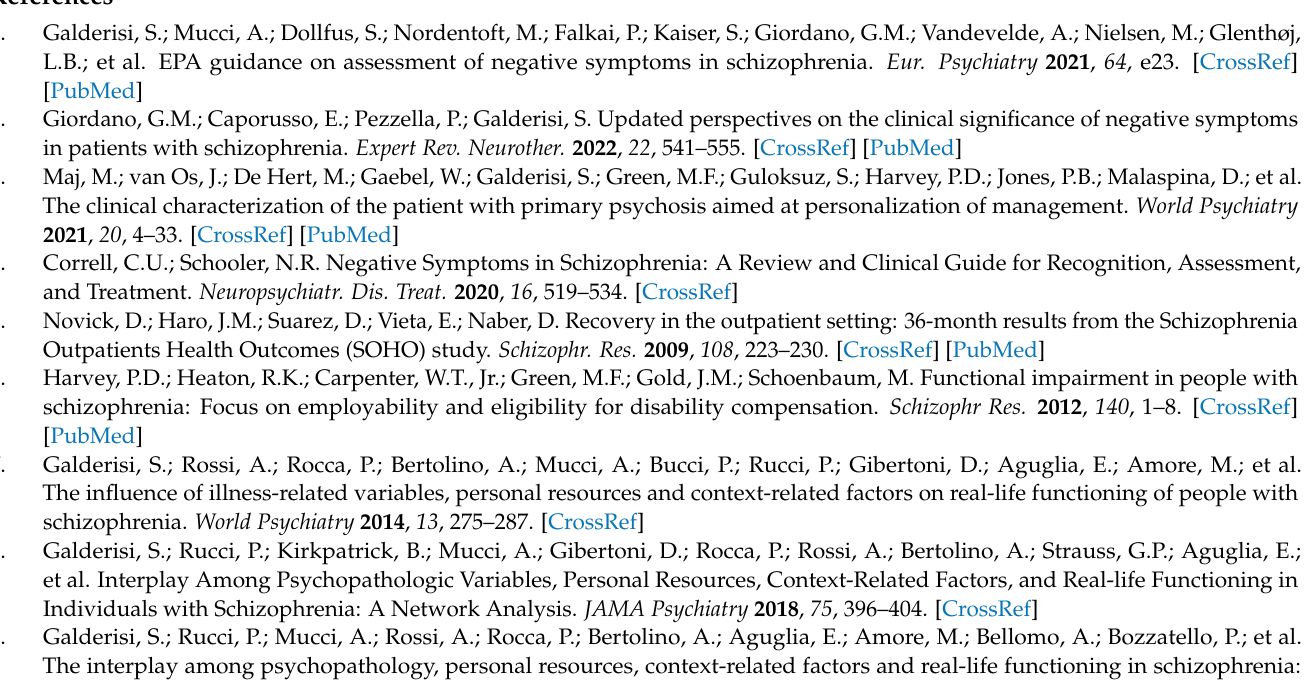
Table S2: Correlations between BNSS Total score and resting-state activity; Section: Members of the Italian Network for Research on